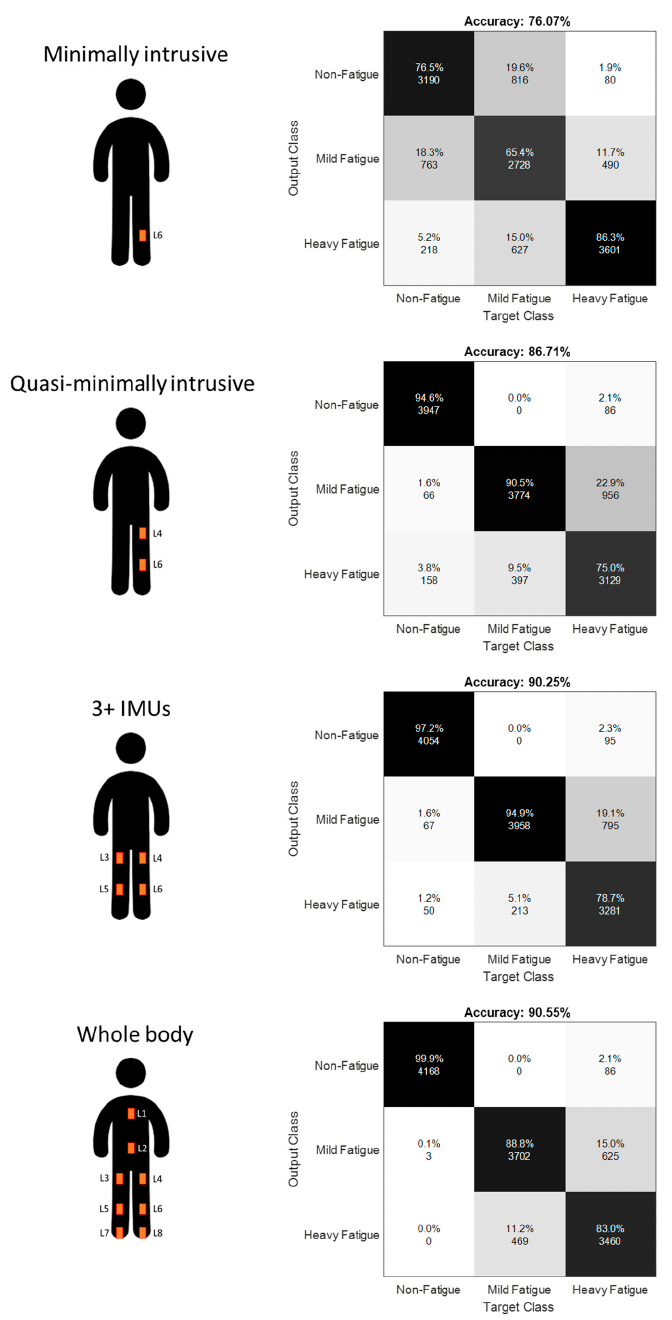
Figure 5. Aggregate confusion matrices for the IMU configurations resulting in higher accuracy in each category.